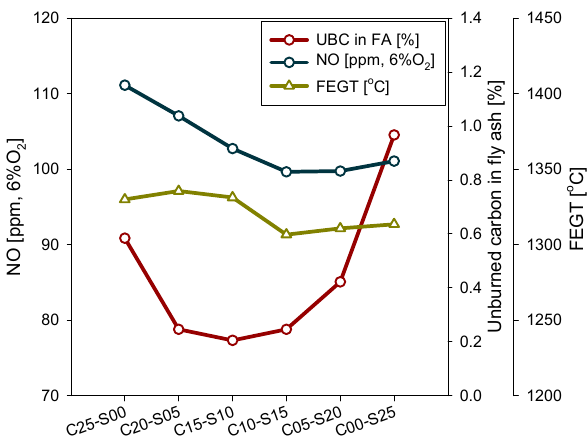
Figure 11. Comparison of NOx emission, UBC in fly ash, and FEGT for different CCOFA/SOFA distributions (total OFA ratio fixed at 25%).